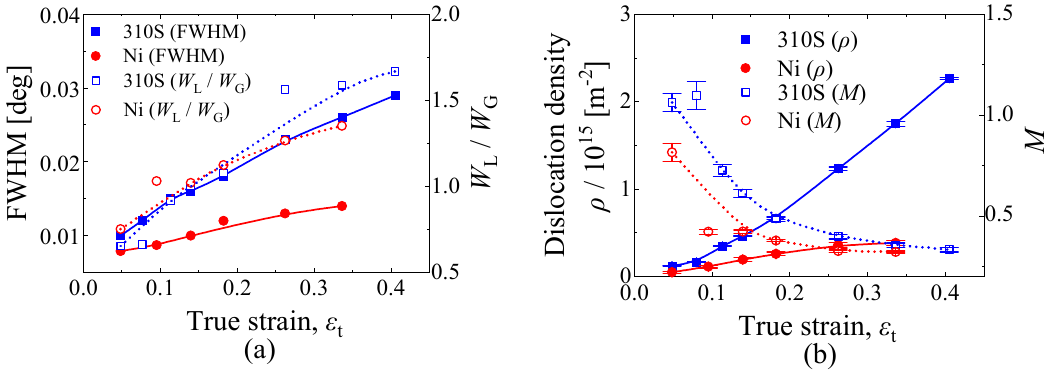
Figure 6. Variations due to true strain for the 310S and Ni specimens in ( a ) FWHMs and W L / W G of 220 reflection; ( b ) dislocation density and M .